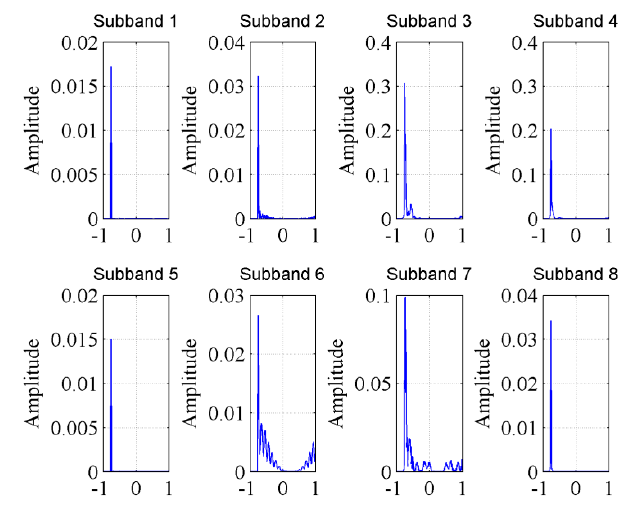
Figure 8. Amplitude spectrum of eight sub-bands.